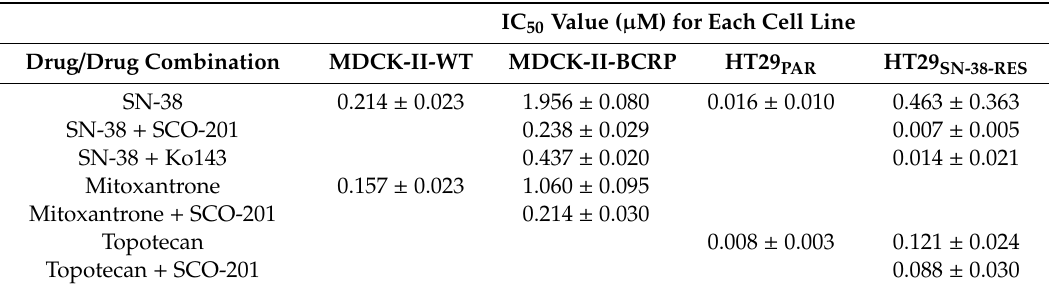
Table 1. IC 50 values of anti-cancer drugs in the presence / absence of SCO-201 or Ko143. IC 50 Value ( µ M) for Each Cell